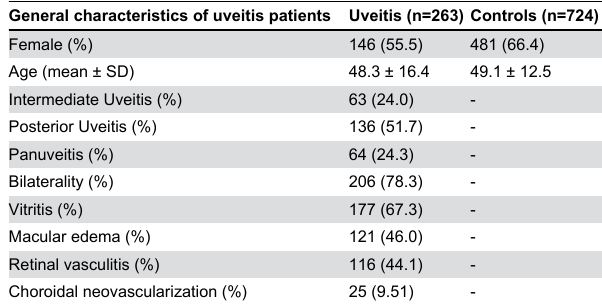
Table 1. Clinical and demographic features of uveitis